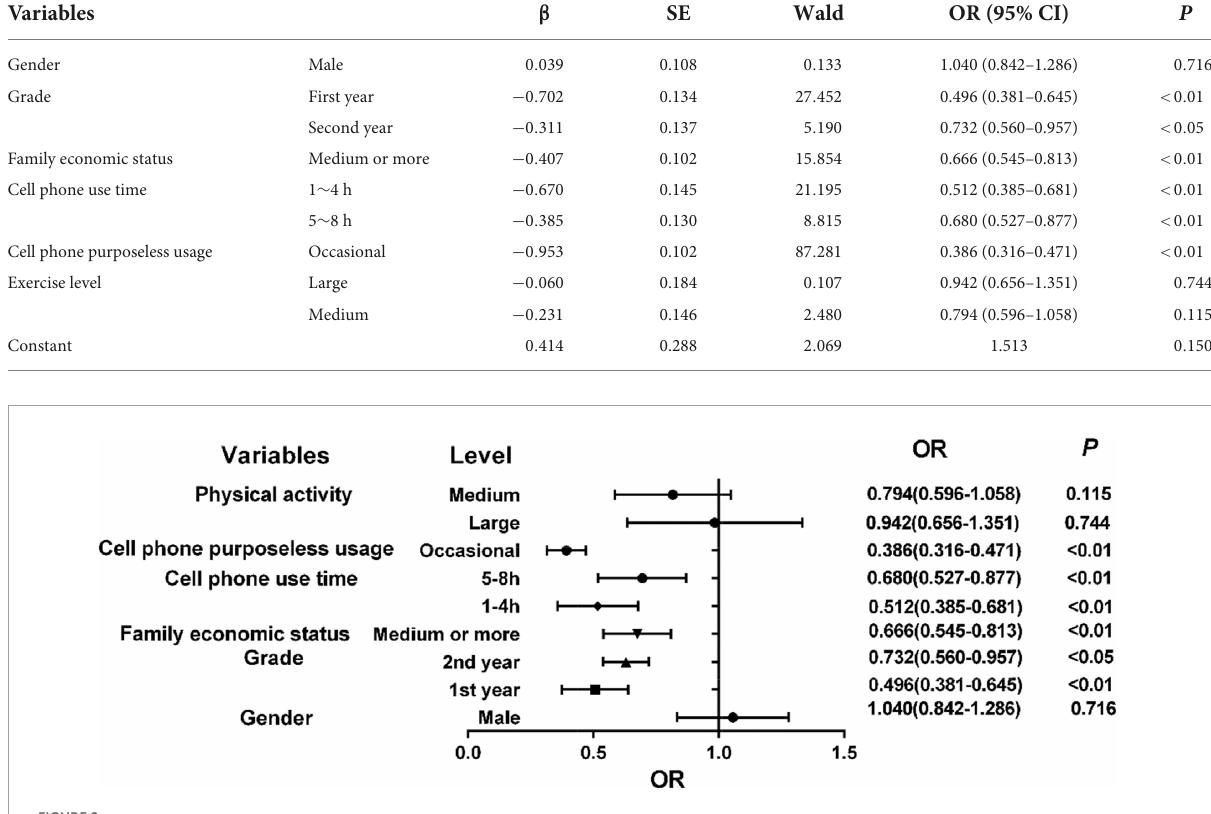
FIGURE2 Results of multi-factor logistic regression analysis of sleep quality